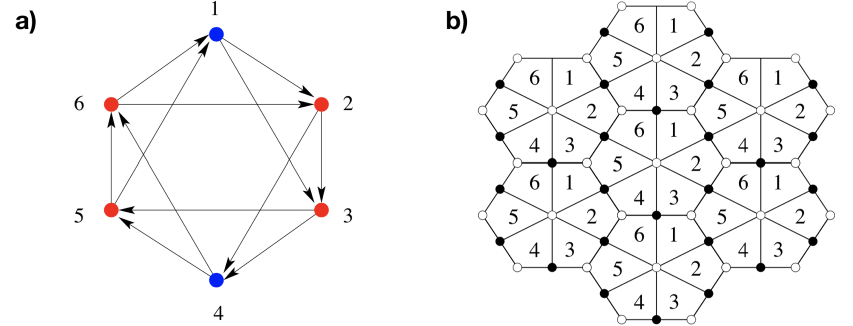
Figure 2 . The quiver and dimer diagrams describing the gauge theory on D3-branes at the tip of the complex cone over dP 3